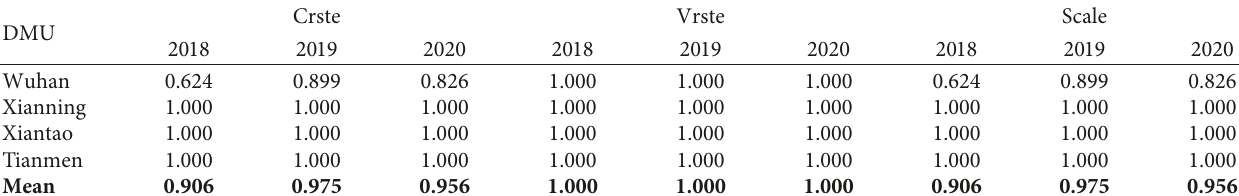
Table 6: Calculation results of manufacturing innovation performance of four cities in the Wuhan city circle, 2018–2020. Crste Vrste DMU